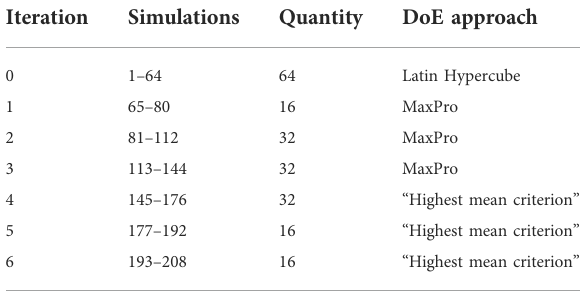
TABLE 3 Iterations of simulations with corresponding selection